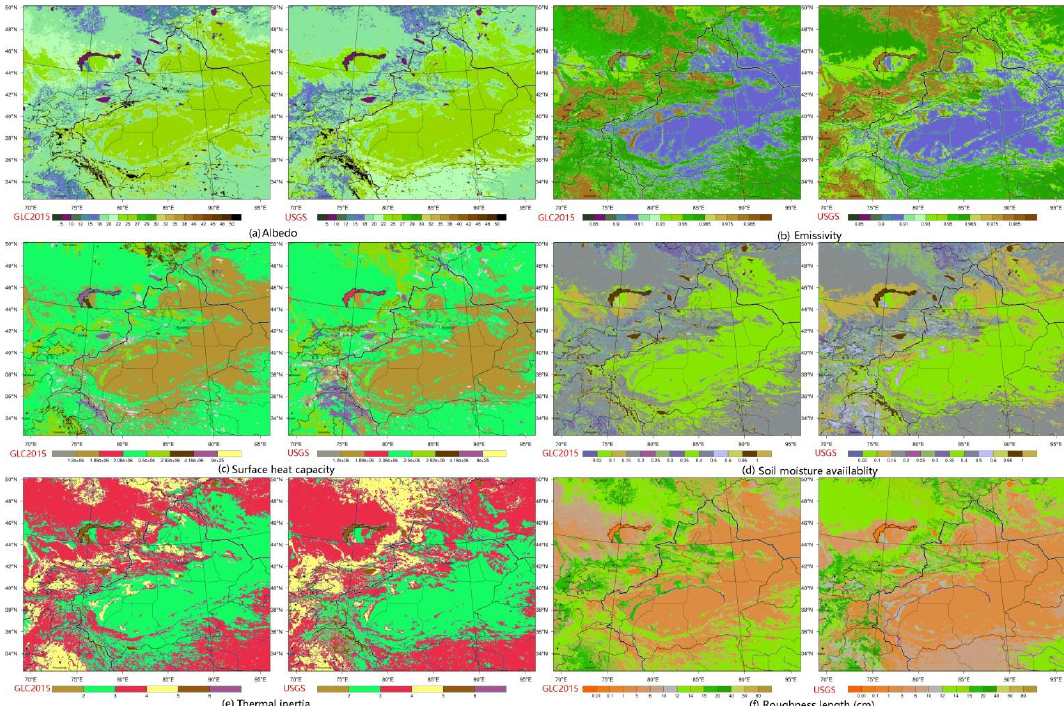
Figure 4. Spatial distribution of the six main physical land parameters in the GLC2015 and USGS land-use datasets for D02: ( a ) surface albedo (%), ( b ) surface emissivity, ( c ) surface heat capacity, ( d ) soil moisture availability, ( e ) thermal inertia, and ( f ) roughness length (cm).